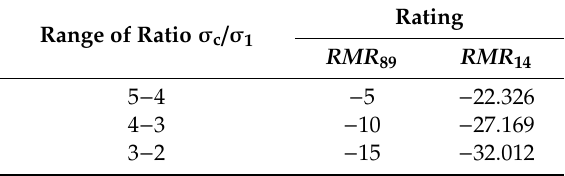
Table 4. Stress adjustment factor selection for RMR 89 and RMR 14 based on the strength–stress